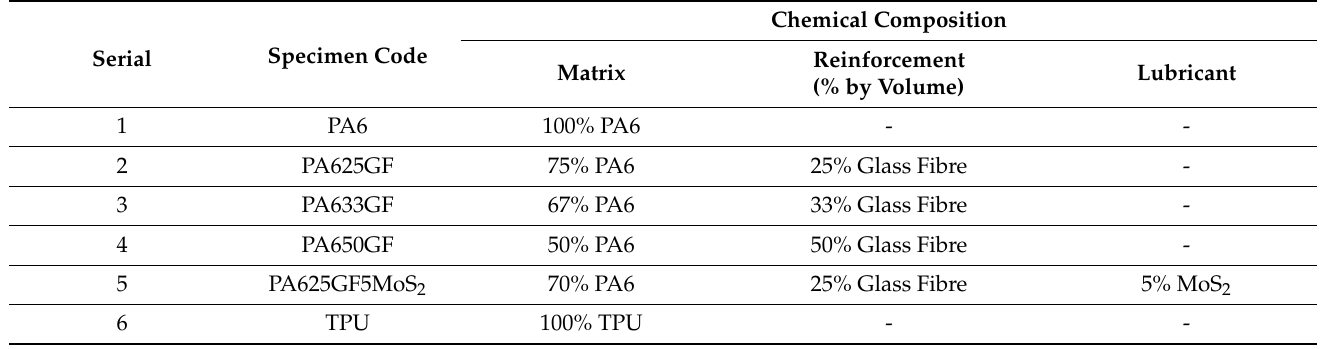
Table 2. Designations and compositions of